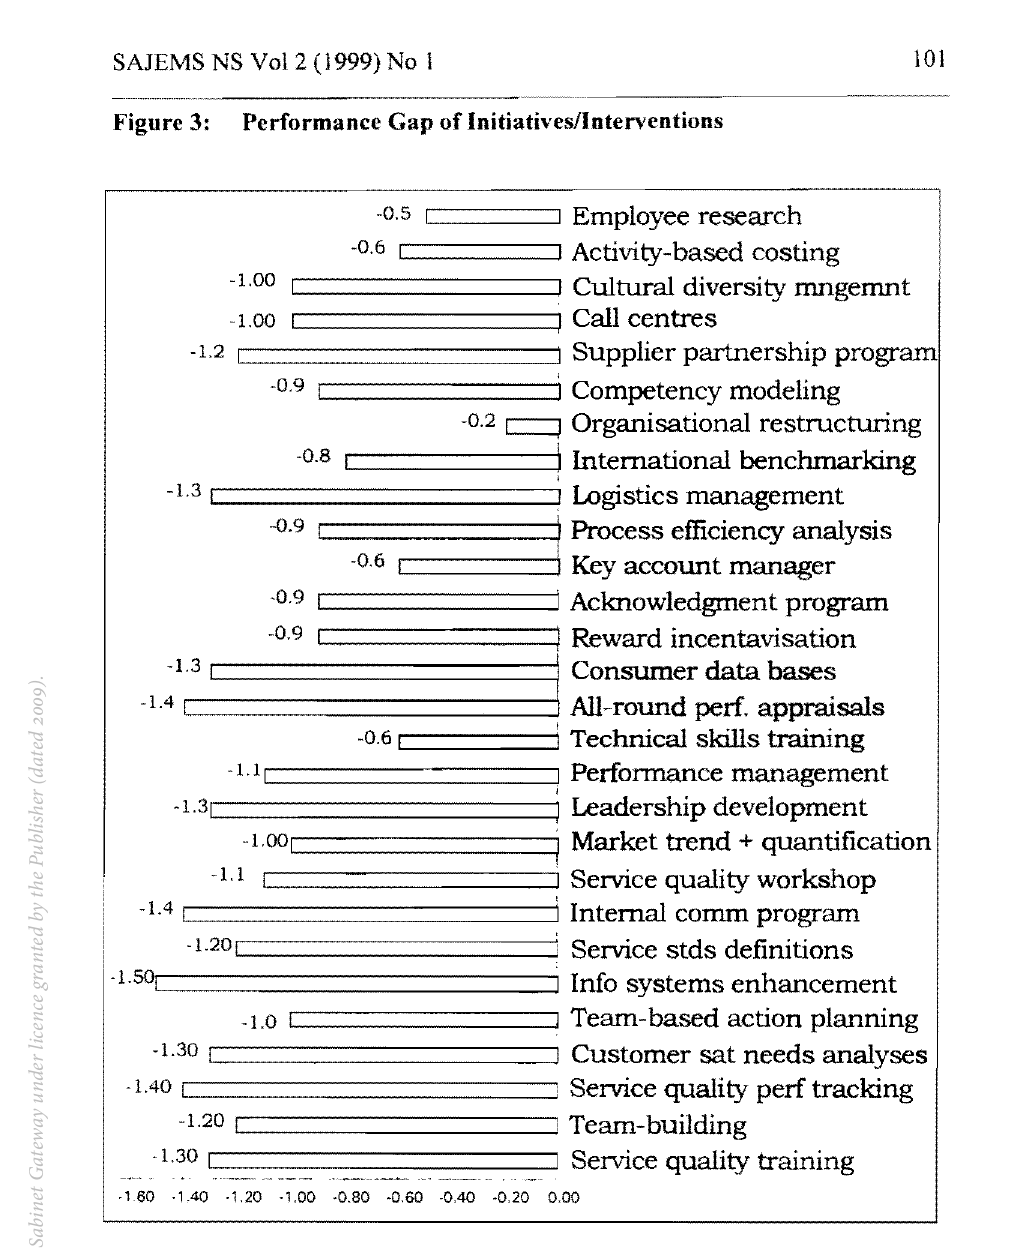
Figure 3: Performance Gap of Initiatives/Interventions -O.S CI ====::JI Employee research -0.6 1 Activity-based costing -1.00 C:::=======:::JI Cultural diversity